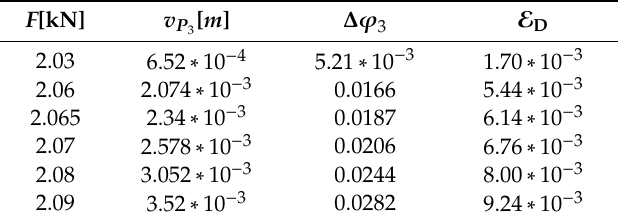
, rotation ∆ ϕ 3 at P 3 and dissipated energy E D . 3